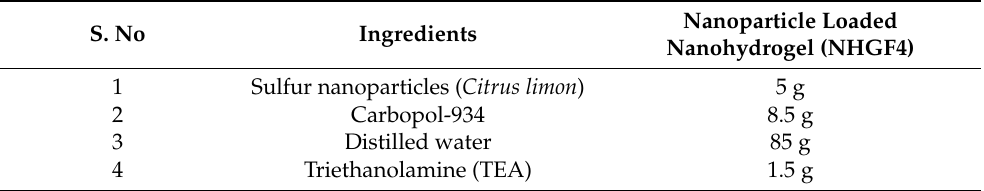
Table 4. Loading of sulfur nanoparticles ( Citrus limon ) in optimized hydrogel formulation. Nanoparticle Loaded S. No Ingredients Nanohydrogel (NHGF4) 1 Sulfur nanoparticles ( Citrus limon ) 5 g 2 Carbopol-934 8.5 g 3 Distilled water 85 g 4 Triethanolamine (TEA) 1.5